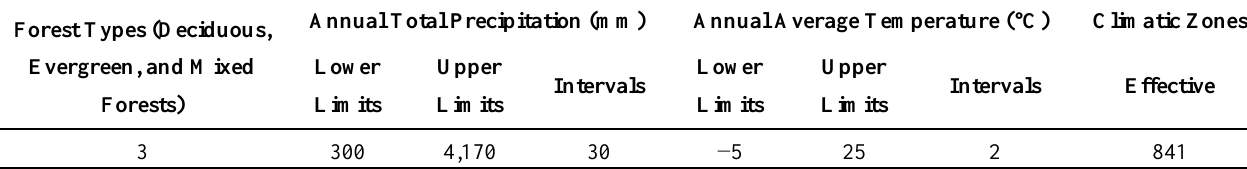
Table 4. Definition of climatic zones for grouping pixels within a forested area. Three forest types with fixed ranges of annual total precipitation (30 mm intervals) and annual average temperature (2 °C intervals) yield a total of 5805 segments (3 × 129 × 15). Of these, only 841 climatic zones have at least one GLAS